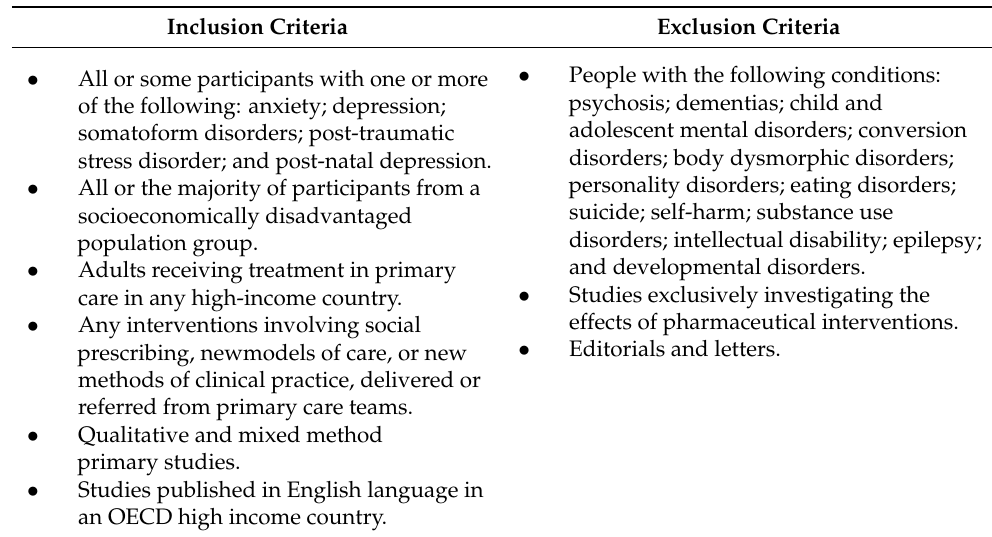
Table 1. Eligibility criteria. Inclusion Criteria Exclusion